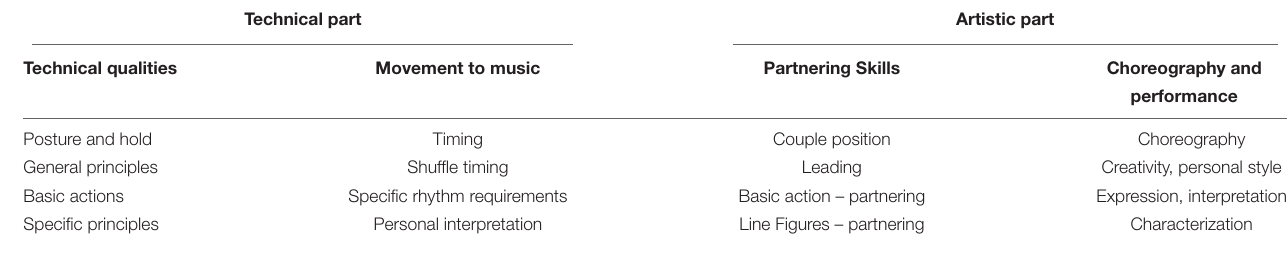
TABLE 1 | Judging criteria issued by the World DanceSport Federation